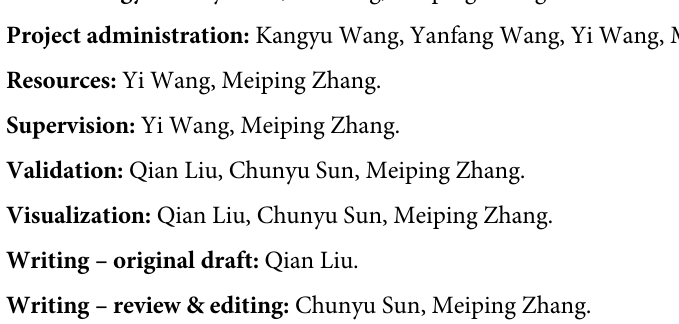
S2 Fig. The conserved motif outside the NAC domain of the SNAC genes in Arabidopsis, rice and ginseng. S1 Table. The transcript sequences of the PgNAC genes identified in this study. S2 Table. Alignment of 251 PgNAC transcripts to the ginseng genome, the ginseng NAC gene database and ginseng protein database. S3 Table. The cloned NAC genes of Arabidopsis thaliana ( At ) and rice ( Oryza sativ a, Os ) used as the evolutionary controls for phylogenetic analysis of the PgNAC gene family. S4 Table. Annotation and GO functional categorization of the PgNAC gene transcripts. S5 Table. Expressions of the PgNAC transcripts in 14 tissues of a four-year-old ginseng plant, four-year-old plant roots of 42 genotypes (cultivars) and the roots of four different year-old